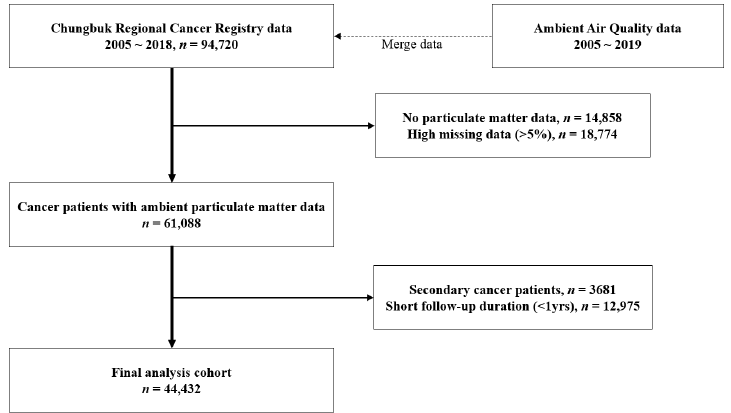
Figure 1. Flowchart of study cohort selection.